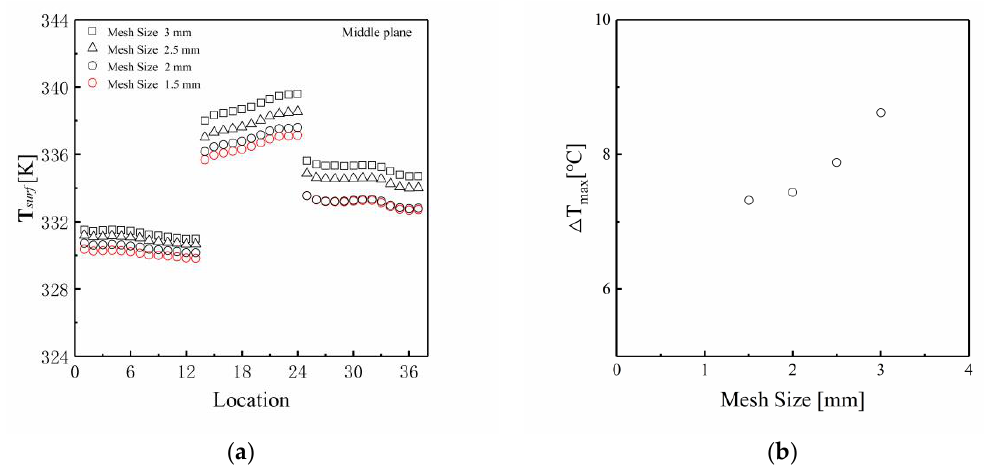
Figure 3. ( a ) Surface temperature of pebbles under four different mesh sizes; ( b ) maximum temperature difference.